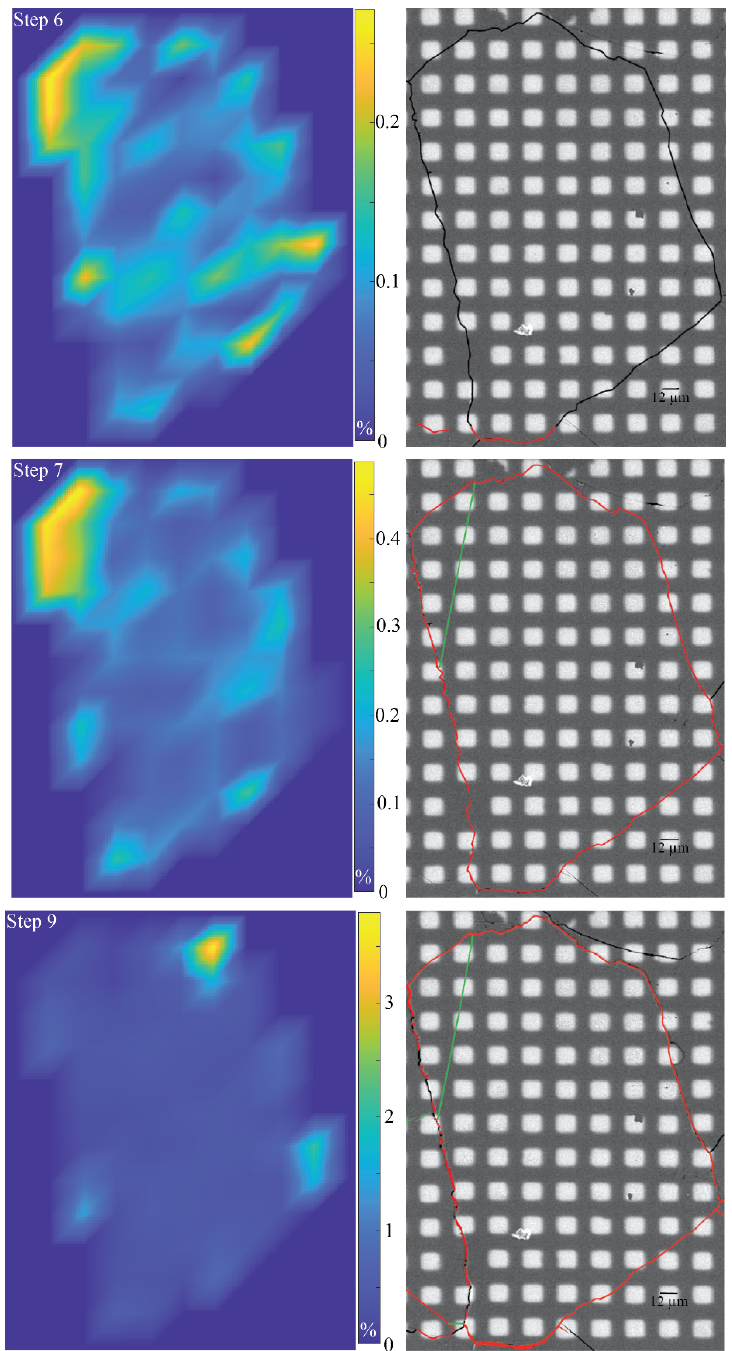
Figure 20. Equivalent Von Mises deformation map of crystal 13 at different steps of sample defor- mation. The black lines represent the grain boundaries. The green lines show the twinned planes. The red lines show the fracture